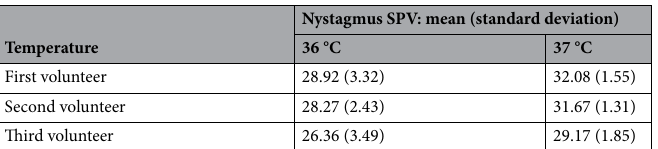
Table 1. The SPV of 3 volunteers at SCCs’ temperature of 36 °C and 37 °C, respectively. Temperature in the table represents the temperature of SCCs. The unit of SPV is